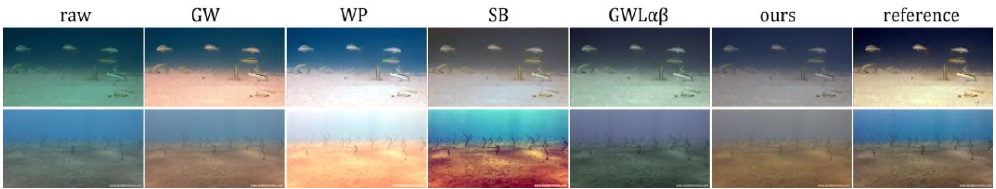
Figure 6. Comparisons on low backscatter scenes. From left to right are raw underwater images, the results of gray-world (GW) method, white-patch (WP) method, statistical-based (SB) method [21], Bianco’s (GWLαβ) method [37], proposed method and reference images.